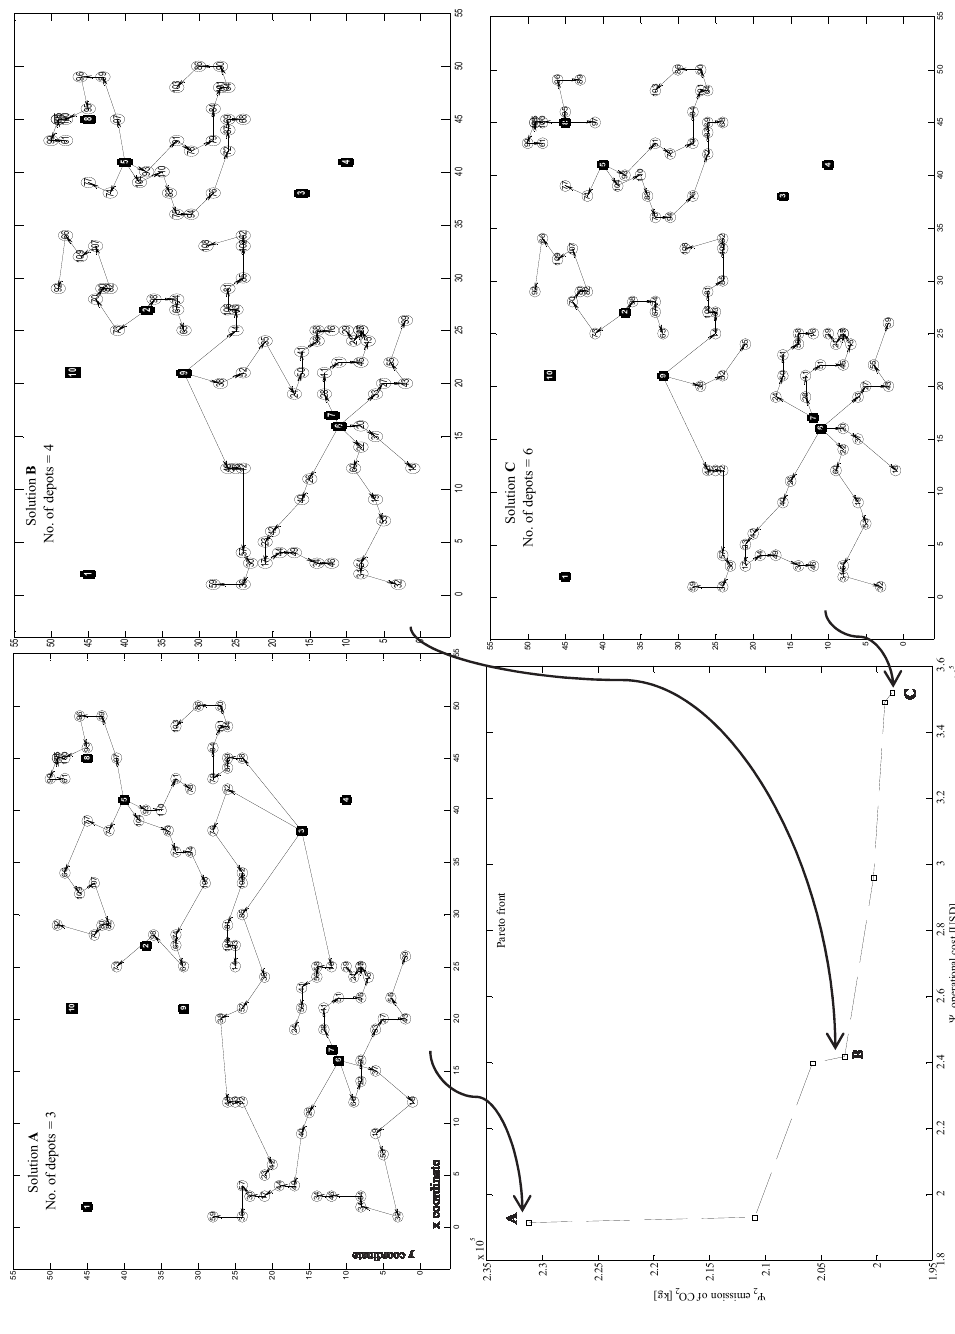
Fig. 1. Pareto front and three representative optimal solutions for the instance 100_10_2b used by Prins et al.